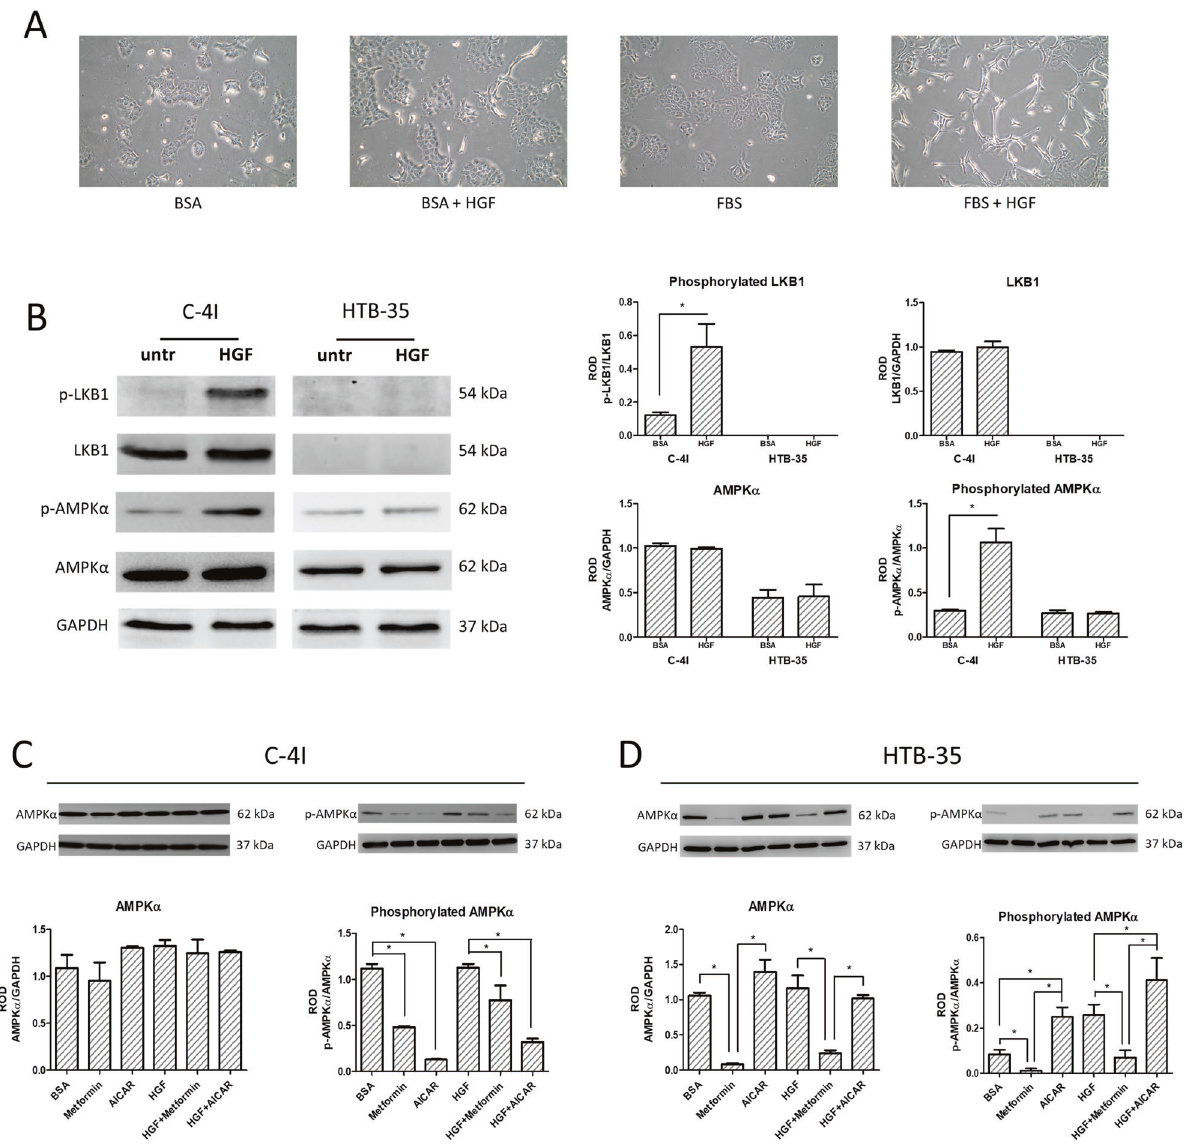
Fig. 2 HGF factor in fl uences phenotype of C-4I cells and expression of catalytic subunit AMPK α 1. Observation of C-4I cell phenotype change after incubation with HGF, both in medium containing 0.5% BSA and 10% FBS ( A ) (white bar represents 100 µm). Evaluation of LKB1 and AMPK α expression and activation in C-4I and HTB-35 cells after 1 h HGF treatment ( B ). Expression and activation of AMPK α subunit after incubation with HGF and AMPK kinase activators (metformin and AICAR) in C-4I ( C ) and HTB-35 ( D ) cells after 24 h incubation. Membrane pictures show representative results of three independent experiments. Quantitative results presented on bar graphs are based on densitometry of the analyzed gene to the reference gene. Data are presented as mean ± SEM ( n = 3). Asterisks indicate statistically signi fi cant differences ( p <